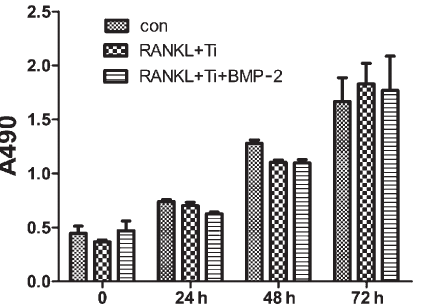
Figure 6. Neither the BMP-2 nor titanium (Ti) particles affect RAW 264.7 cell proliferation. RAW 264.7 cells (control, con) were pretreated with 30 ng/mL RANKL and 150 m g/mL Ti particles for 1 h, then treated or not with 50 ng/mL BMP-2 for 3 days. Data are reported as means±SD cell proliferation as the absorbance ratio at 490 nm.